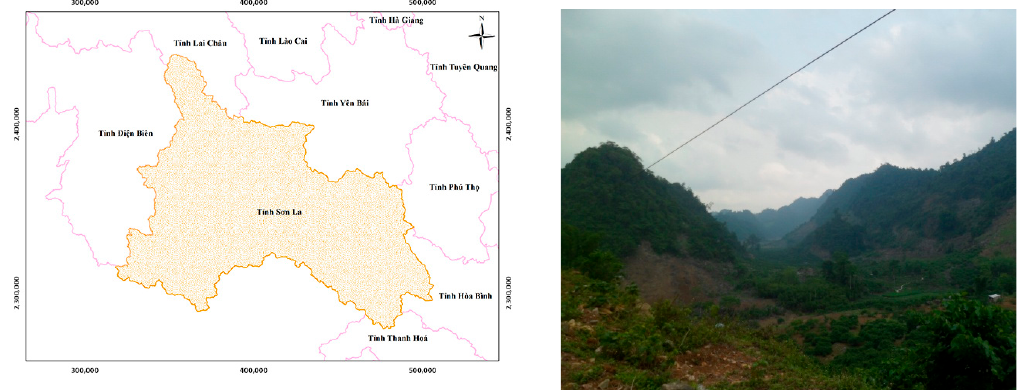
Figure 2. Study area: Son La Province and its typical landscape.